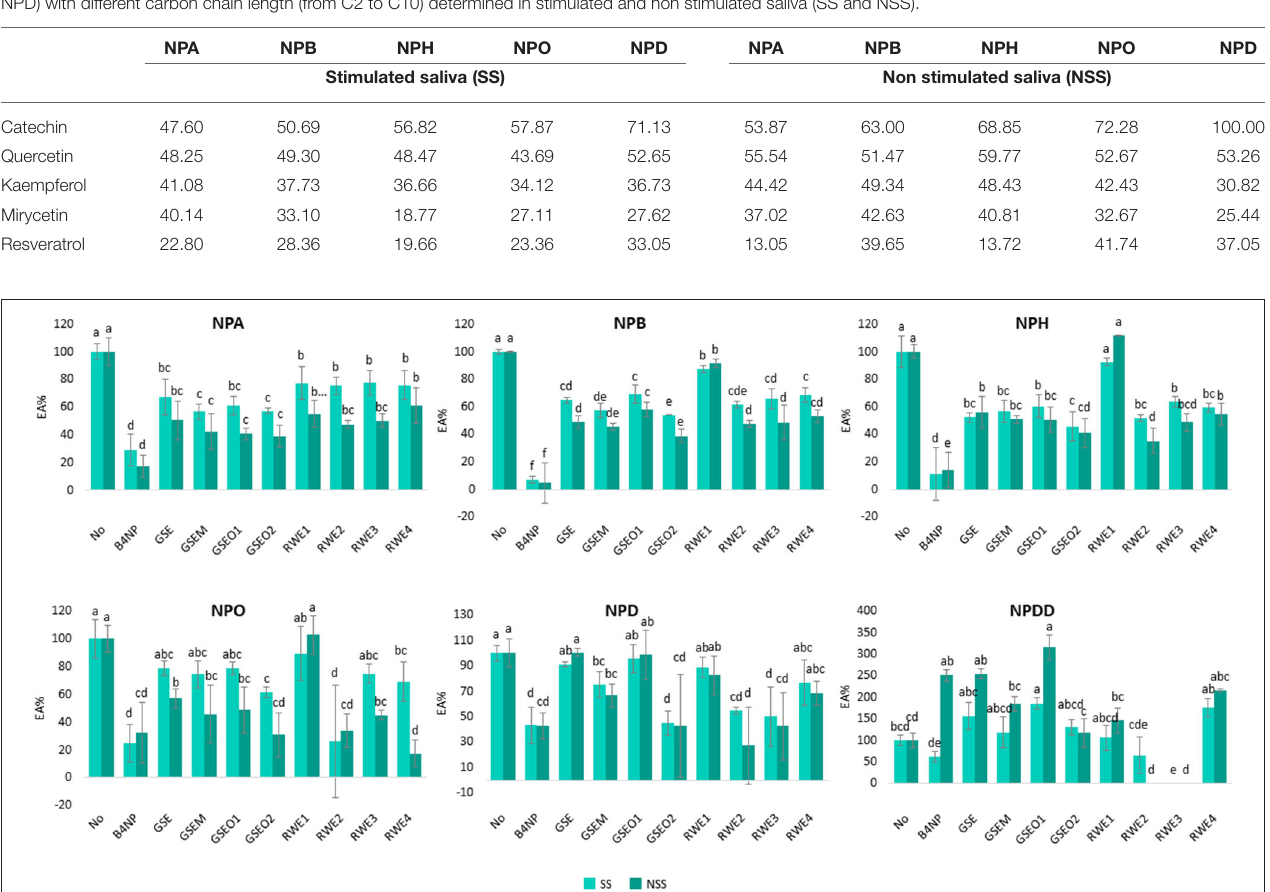
TABLE 3 | Inhibition (%) of EA by single wine polyphenols at the maximum concentrations typically found in wines, toward five p-NP-esters (NPA, NPB, NPH, NPO, and NPD) with different carbon chain length (from C2 to C10) determined in stimulated and non stimulated saliva (SS and NSS).